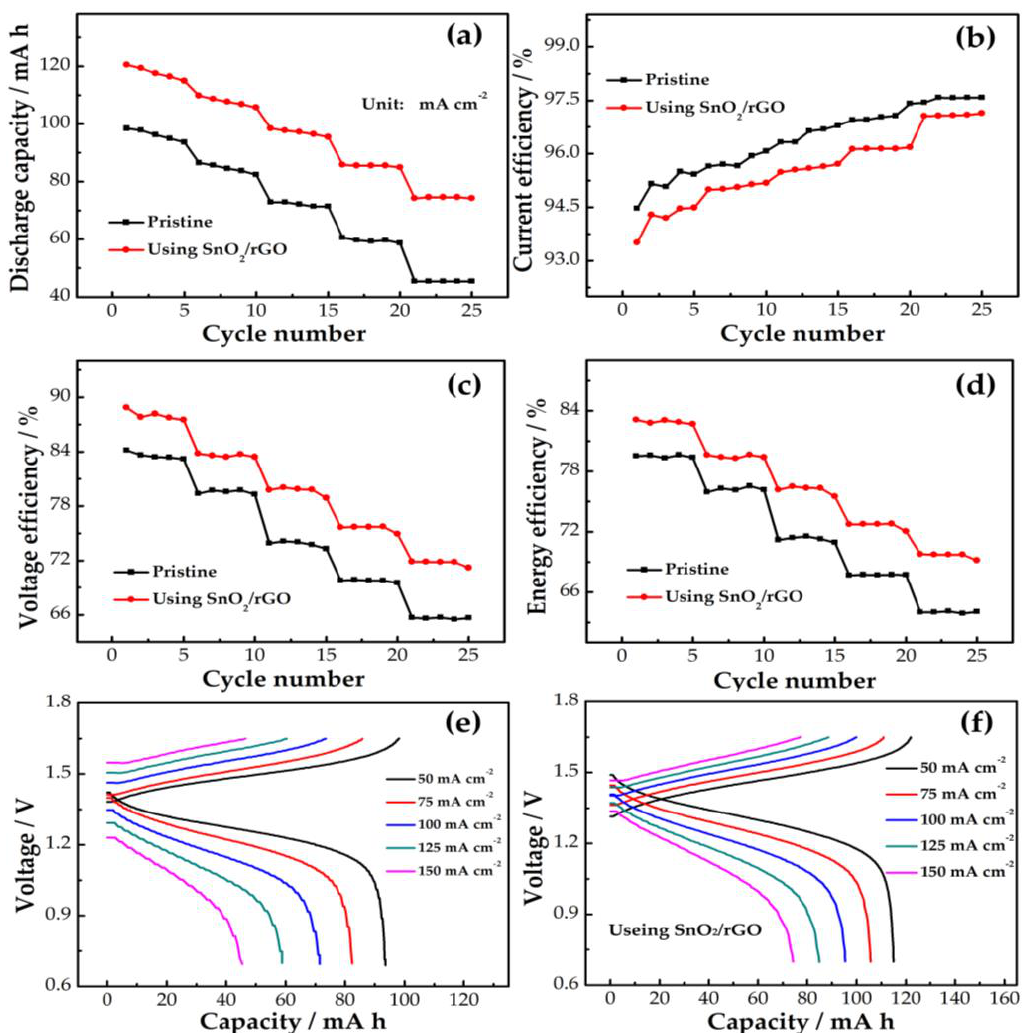
Figure 8. ( a ) Discharge capacity; ( b ) CE, ( c ) VE, and ( d ) EE of cells with and without SnO 2 /rGO; ( e ) charge–discharge curves of pristine cell; ( f ) SnO 2 /rGO modified cell at current density of 50–150 mA cm −2 .